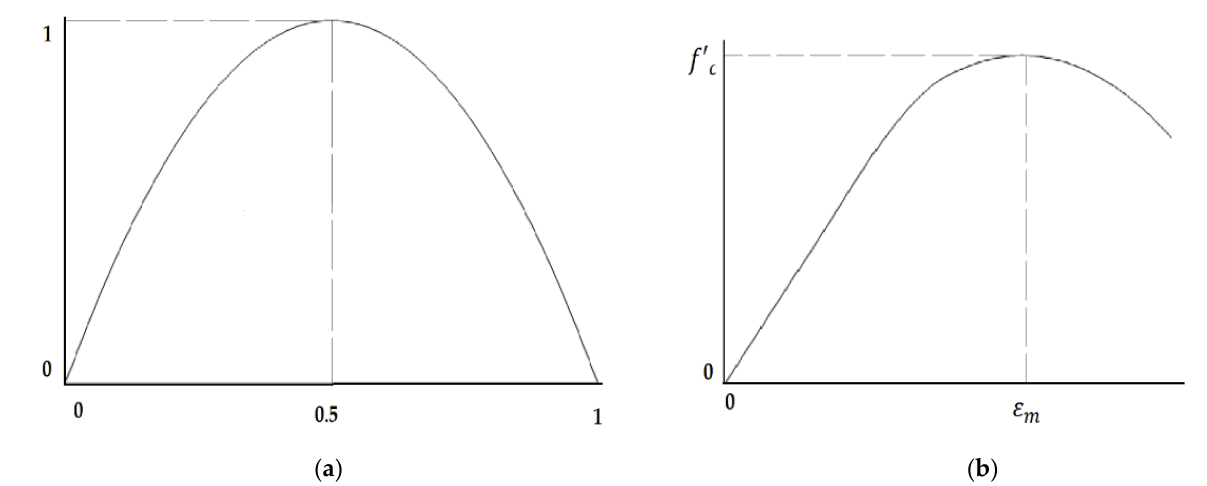
Figure 7. The similarity between ( a ) Logistic Map; and ( b ) the ideological compressive stress – strain curve.